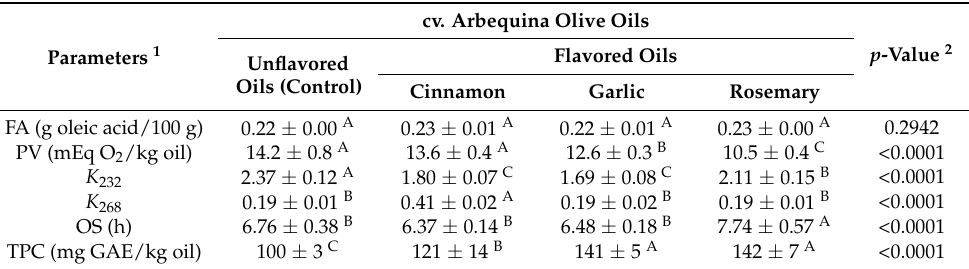
Table 1. Mean values ( ± standard deviation) of free acidity, peroxide value, extinction coefficients, oxidative stability and total phenols contents of unflavored (control) and flavored (cinnamon, garlic or rosemary) olive oils of cv. Arbequina olive oils (for each unflavored or flavored oil: n = 8). cv. Arbequina Olive Oils p -Value 2 Unflavored Flavored Oils Parameters 1 Oils (Control) Cinnamon Garlic Rosemary FA (g oleic acid/100 g) 0.22 ± 0.00 A